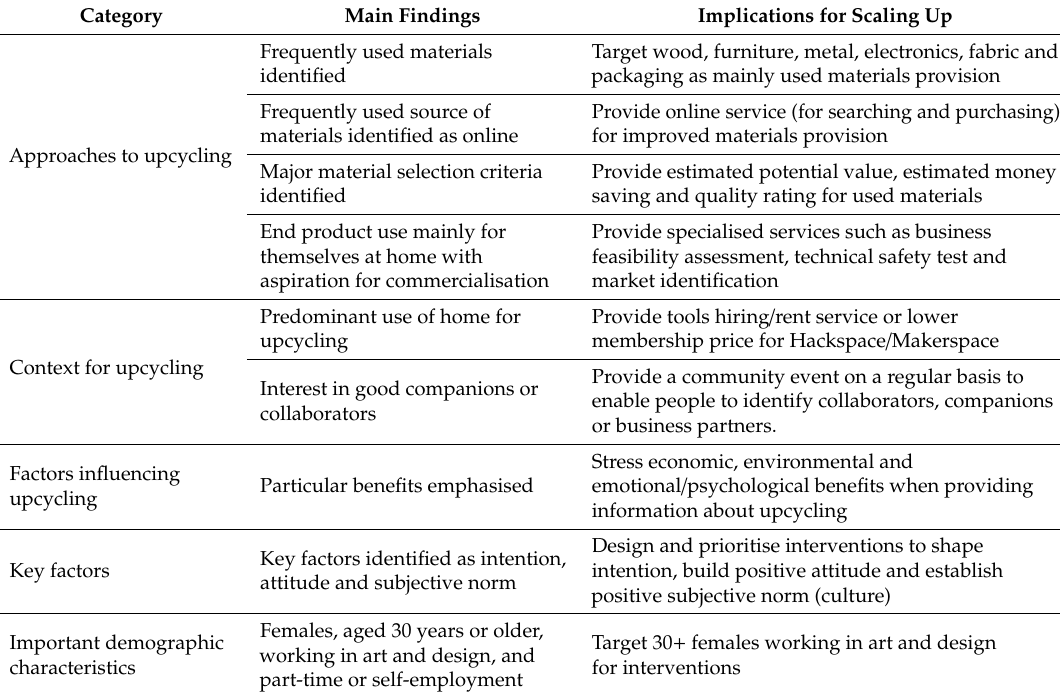
Table 2. Synthesis of the main findings and implications for scaling up upcycling.